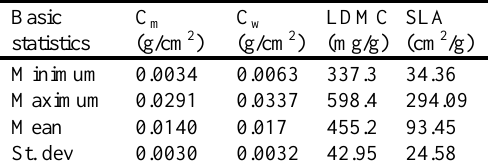
Table 2. Summary statistics of the measured variables in leaf samples. The leaf dry matter content (LDMC), leaf mass per area (Cm), Specific leaf area (SLA) and leaf water content (Cw) were calculated as LDMC = , Cm= , SLA= and Cw where and stand for a given sample’s fresh weight and dry weight respectively and is sample leaf area. Total number of samples is